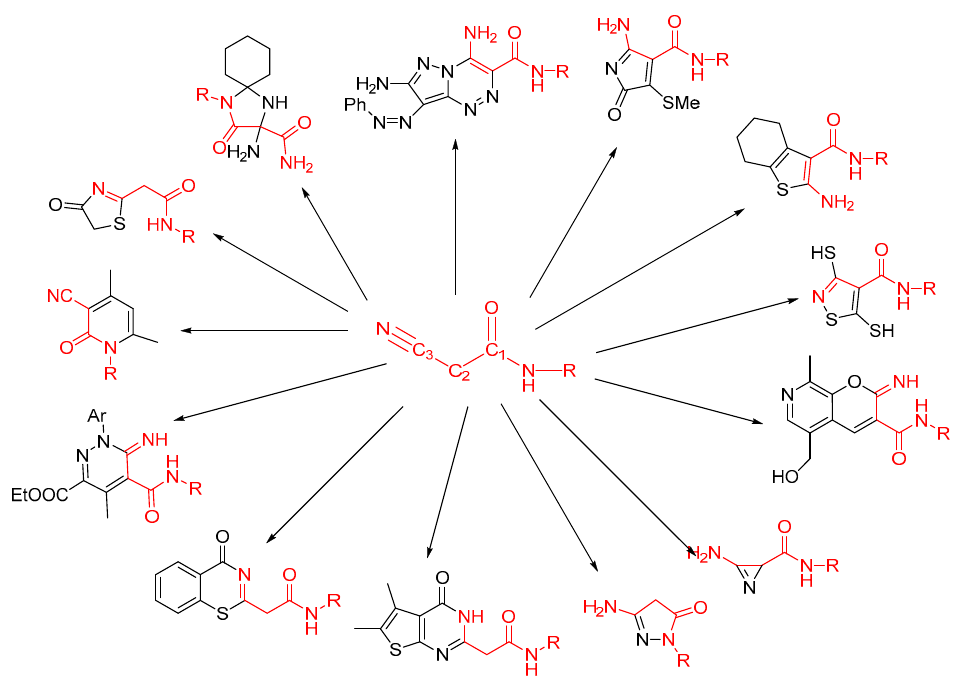
Figure 2. Diverse heterocyclic moieties synthesized from cyanoacetamide.